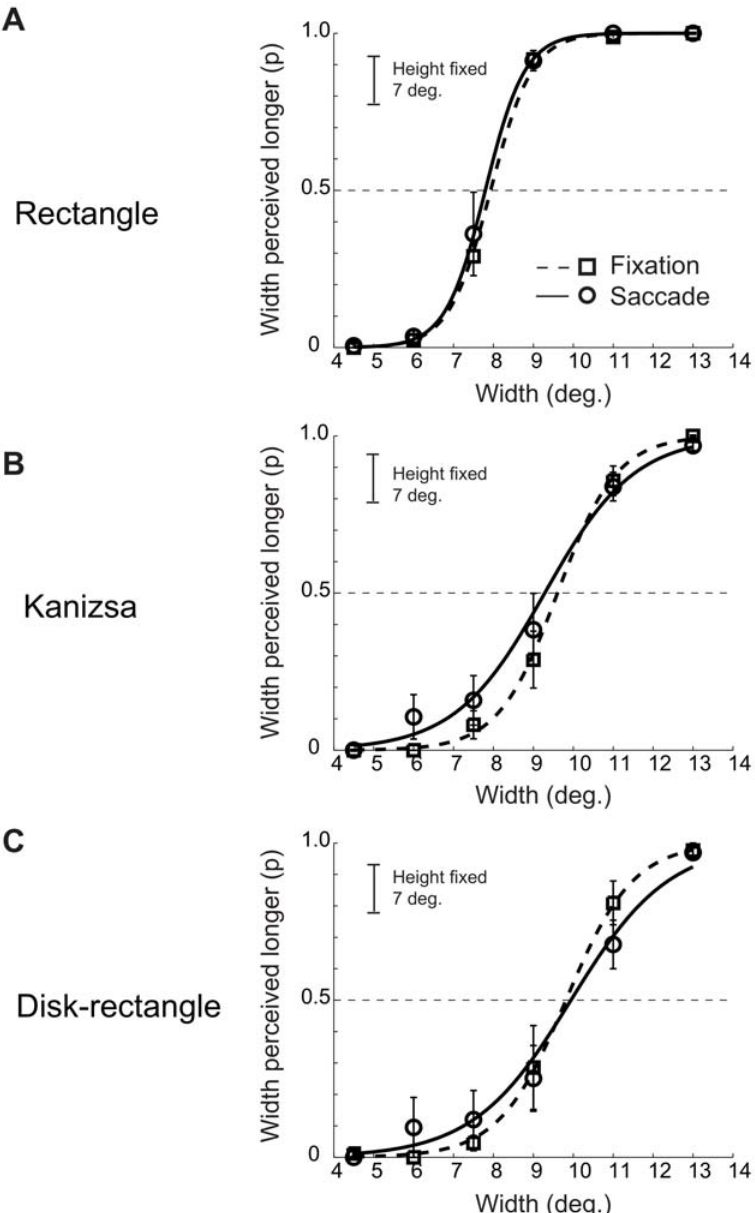
Figure 6. Experiment 1B: Proportion of participants reporting the width was longer than the fixed height. Vertical bars indicate SEMs.